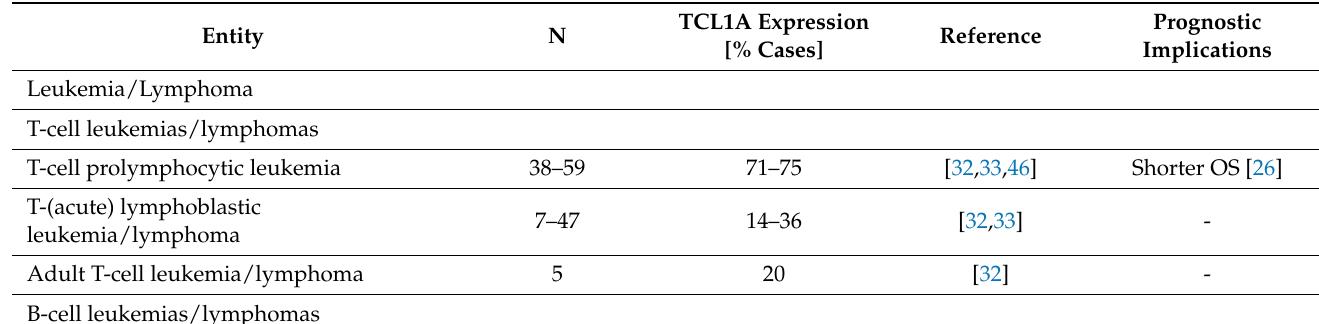
Table 1. Expression of TCL1A in different